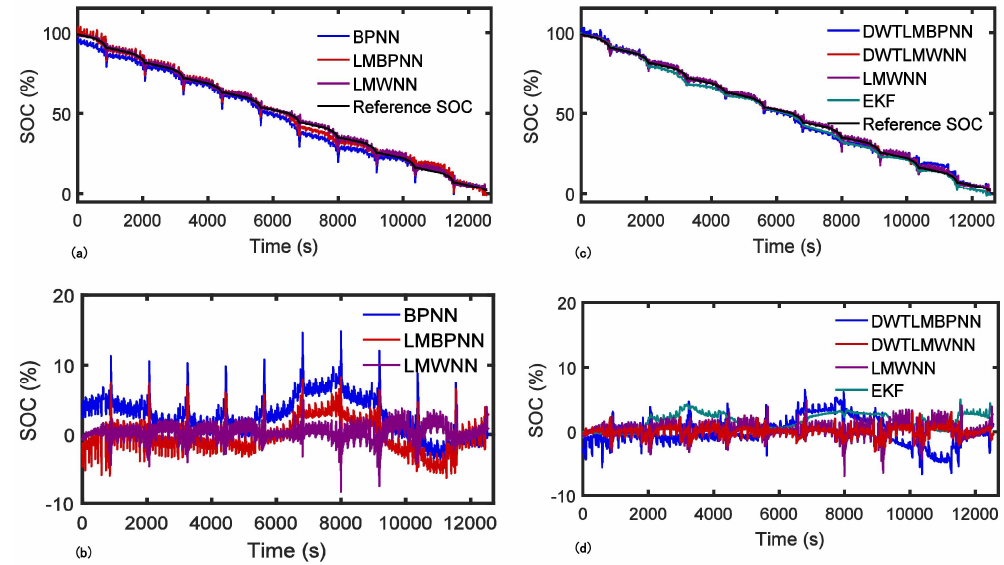
Figure 5. SOC estimation and SOC error under the NEDC: ( a , b ) BPNN, LMBPNN, and LMWNN; ( c , d ) DWTLMBPNN, DWTLMWNN, LMWNN, and EKF.